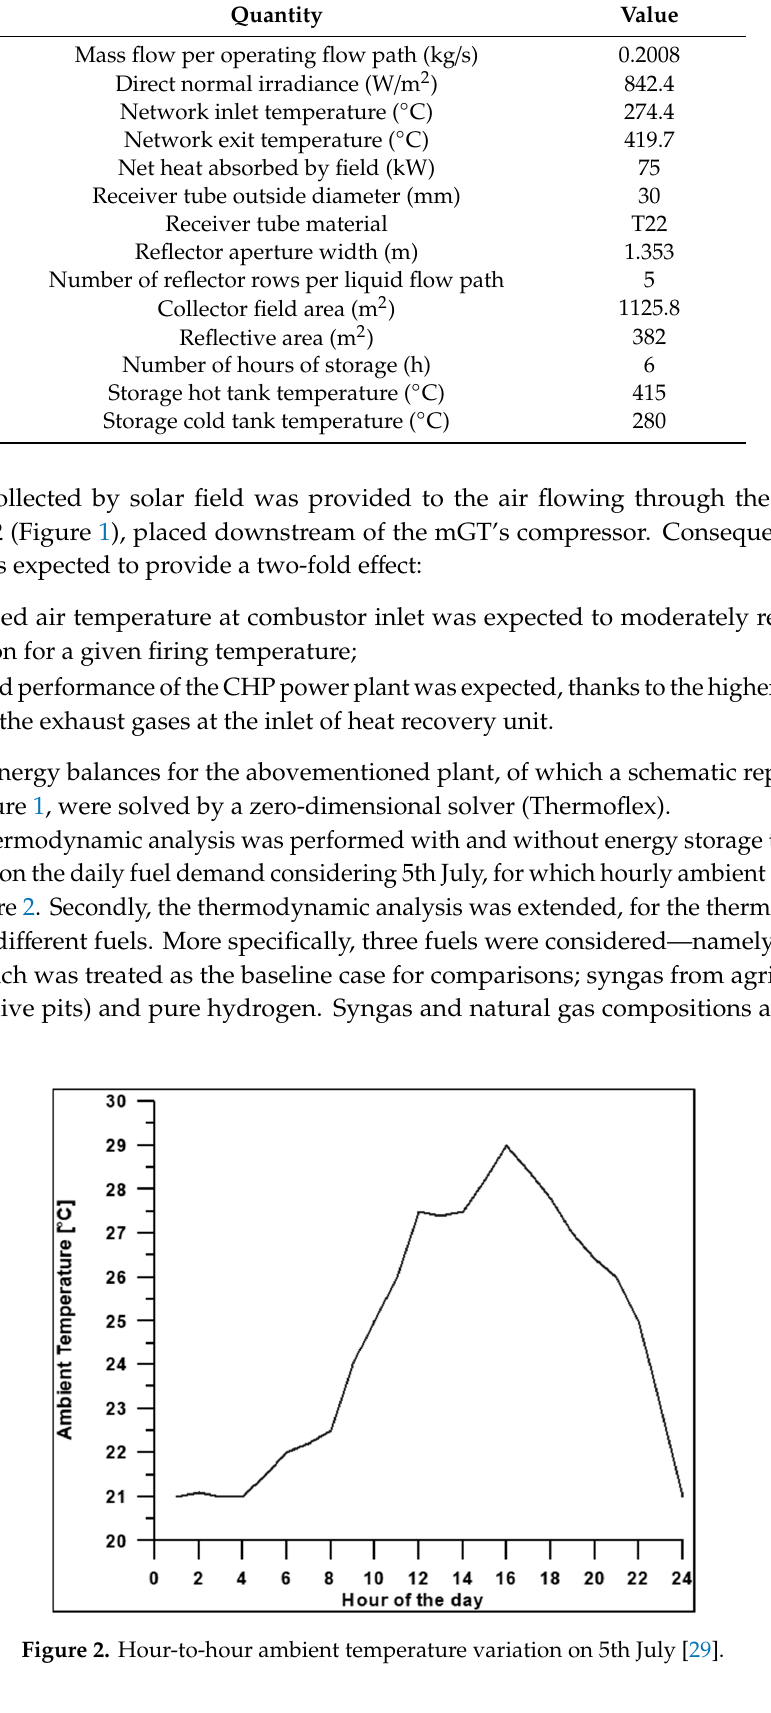
Table 2. Solar field characteristics.